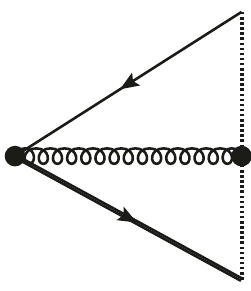
Figure 2 . The leading-power contribution to the correlation function (4.1) with two HQET currents at LO in (cid:11) s